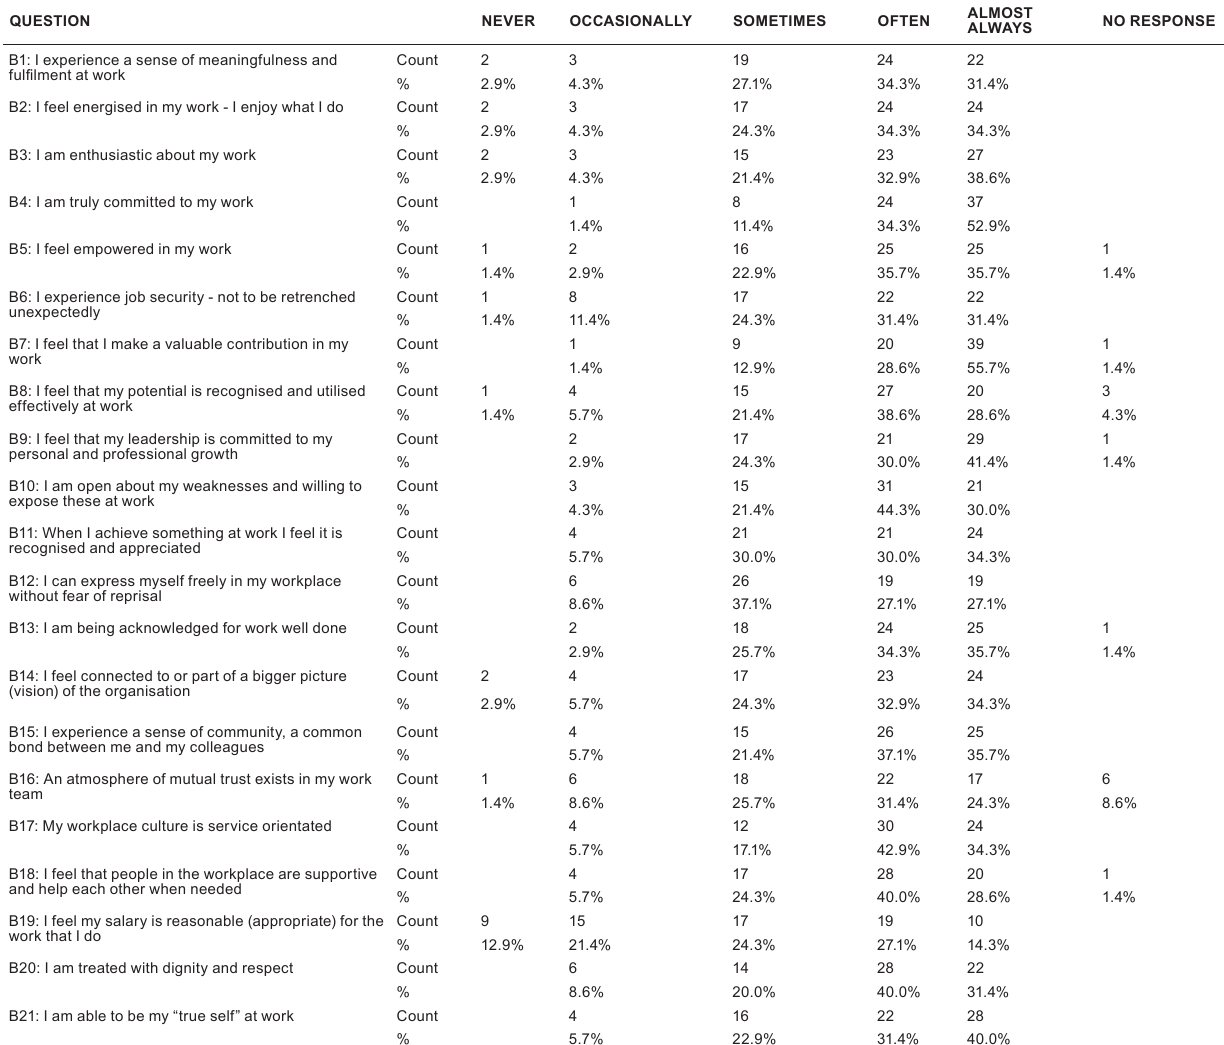
TABLE 11 Results of Questionnaire